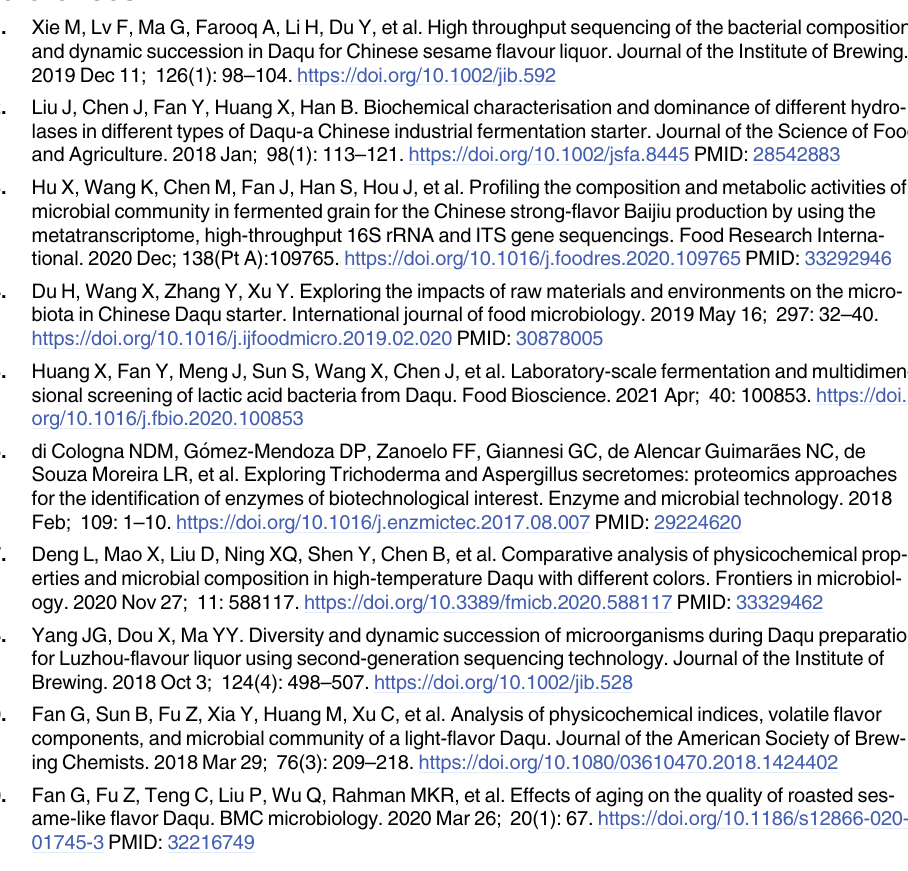
Fig 3. (A) Heatmap of the species distribution at the genus level. (B) Calculated Spearman correlation coefficients of microbes and flavor components and the corresponding plotted correlations of the qualified